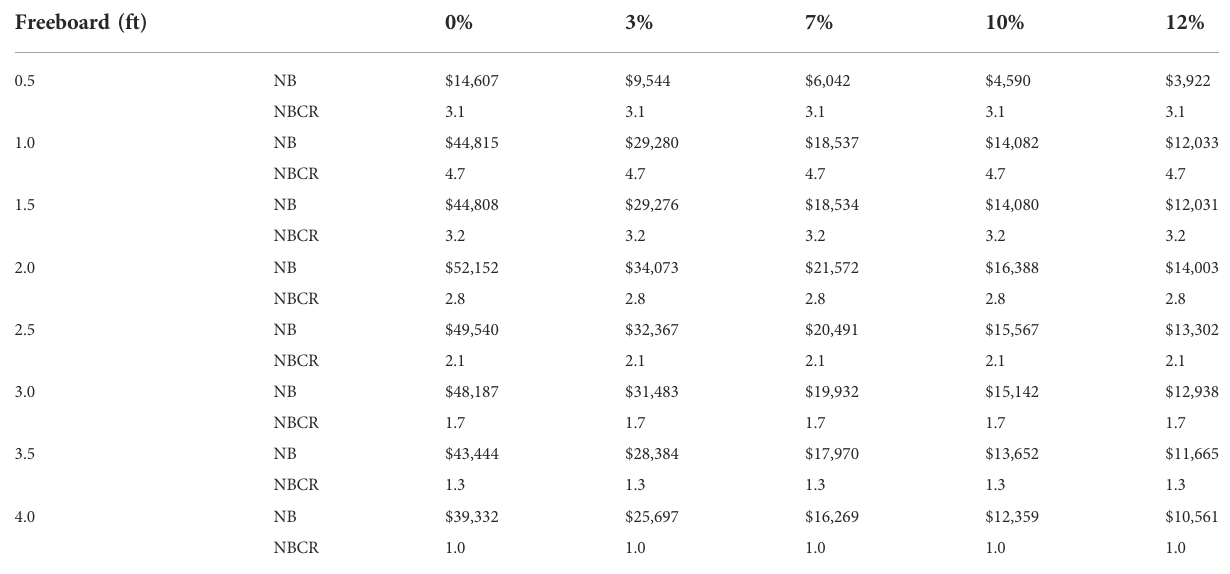
TABLE 6 As in Table 5, but calculated into a mortgage. Freeboard